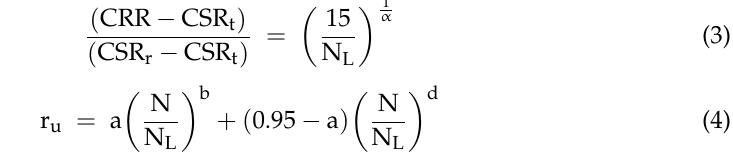
Table 2. Parameters of the pwp model used in the effective stress analyses. Layer CSRt α